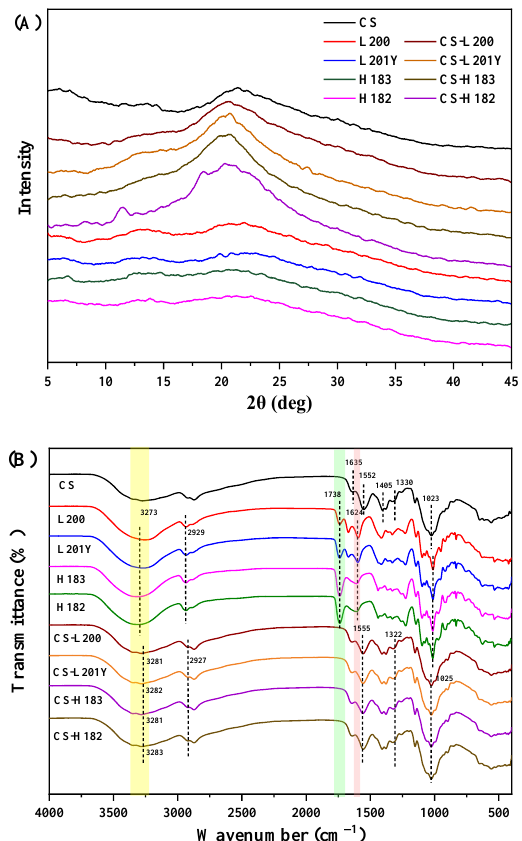
Figure 6. XRD ( A ) and FT-IR ( B ) spectra of different monolayer and bilayer films.